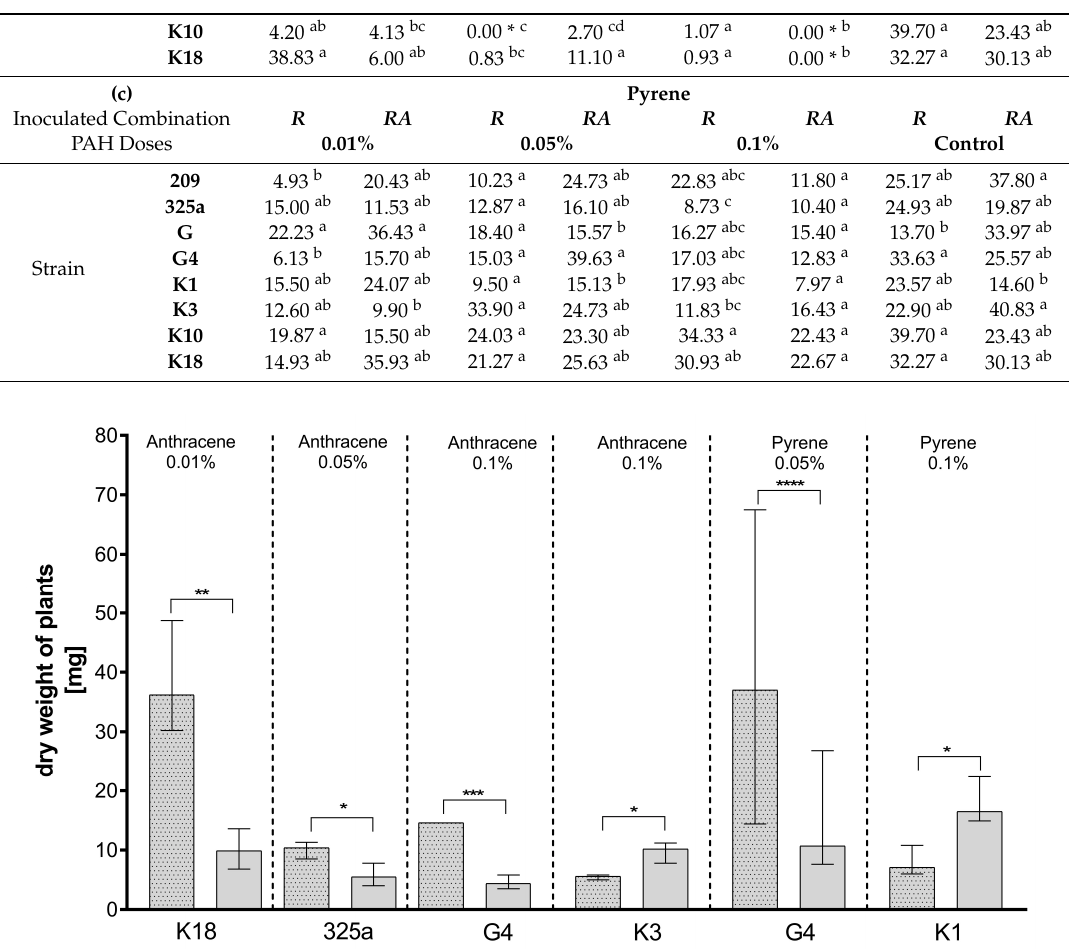
Figure 5. Comparison of the effect of inoculation of clover with only R. leguminosarum strains and with co-inoculation with A. brasilense on dry weight of clover (mg). The dotted posts indicate the co-inoculation with A. brasilense variant. The results are presented as a boxplot with median and 2.5–97.5 percentile. The symbols indicate significant results at: * p ≤ 0.05; ** p ≤ 0.01; *** p ≤ 0.001; **** p ≤ 0.0001; α = 0.05. Figure presents only those strains for which statistically significant differences were noted.